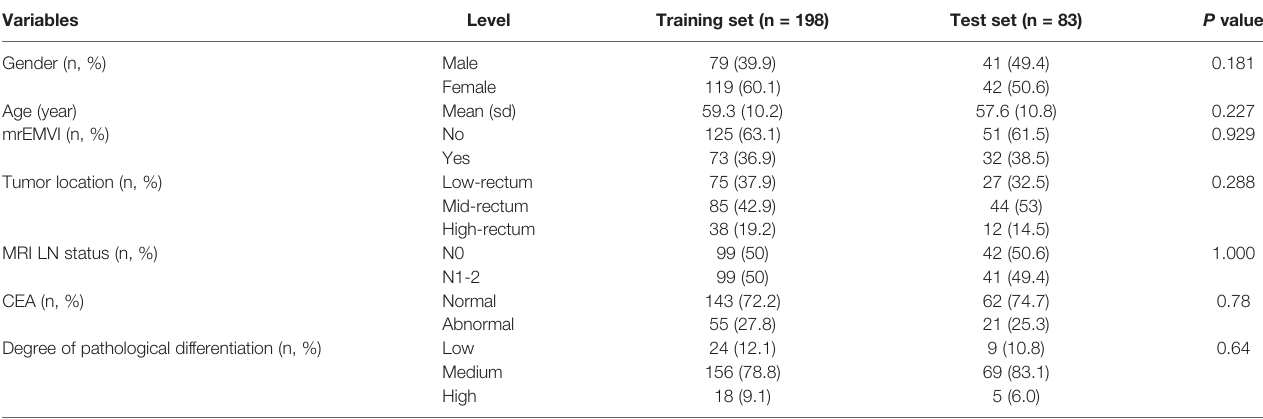
TABLE 1 | Descriptive statistics of the two